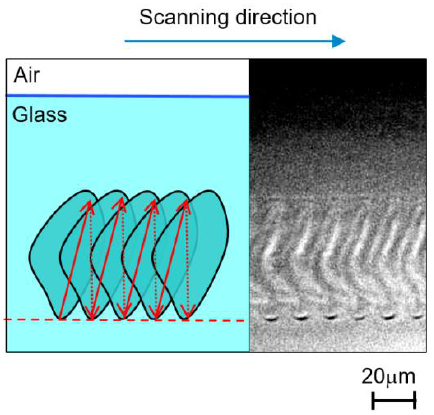
Figure 7. Schematic illustration of observation of molten area from side view direction.